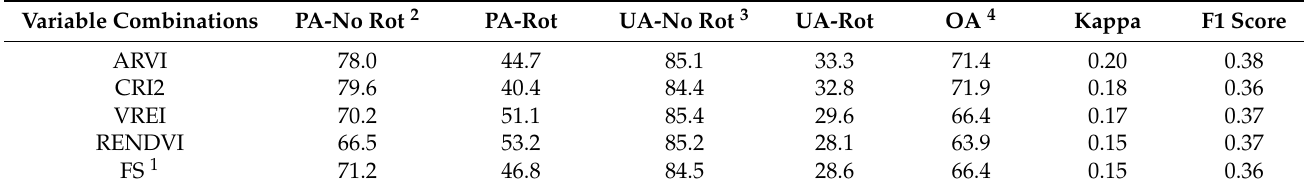
Table 9. Select Model results from the Etnedal study area with image